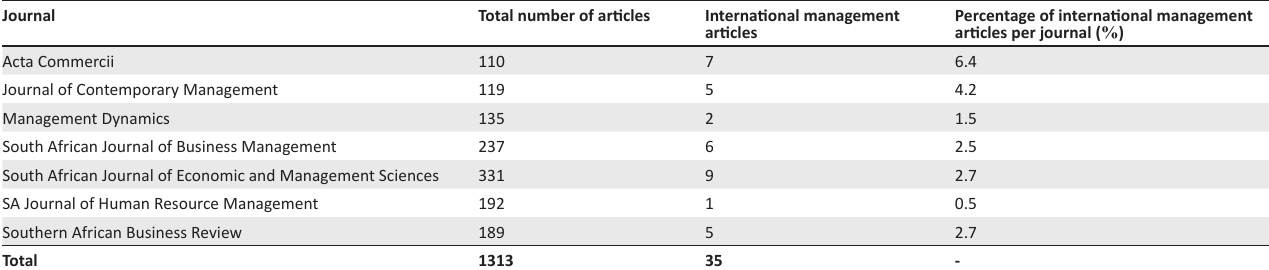
TABLE 2: International management articles by journal (2004–2013).